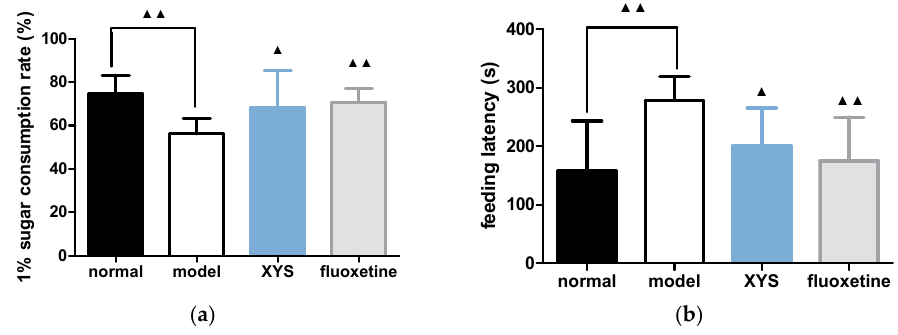
Figure 2. ( a ) Sugar consumption rate; ( b ) feeding latency. The data were expressed as mean ± standard deviation ( (cid:1876)̅ ± s), n = 10. ▲ p < 0.05, ▲▲ p < 0.01, compared with the model group.